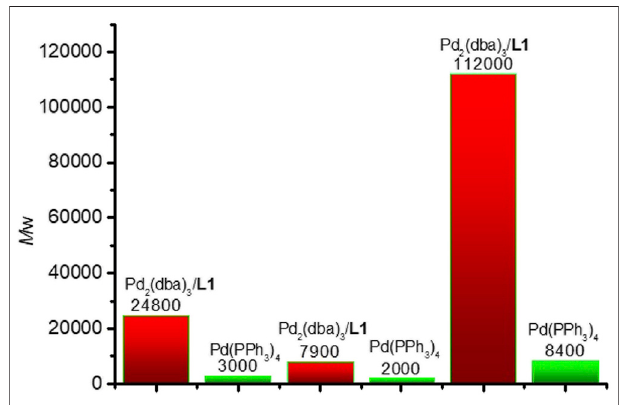
FIGURE 2 | The molecular weight Mw of P1, P2 and P3 with different